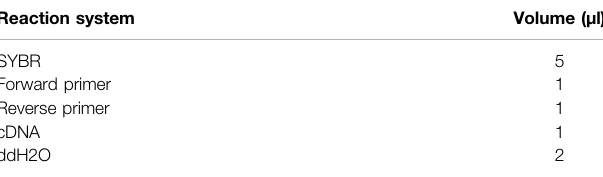
TABLE 1 | Primer names and sequences. TABLE 2 | Q-PCR reaction